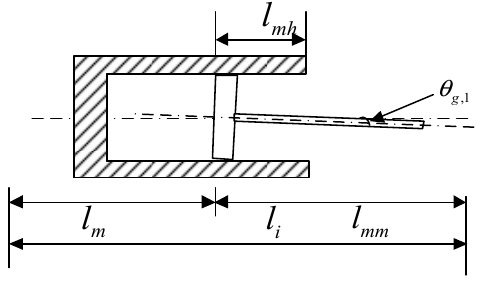
Figure 3. Structure diagram of the flexible deformation.